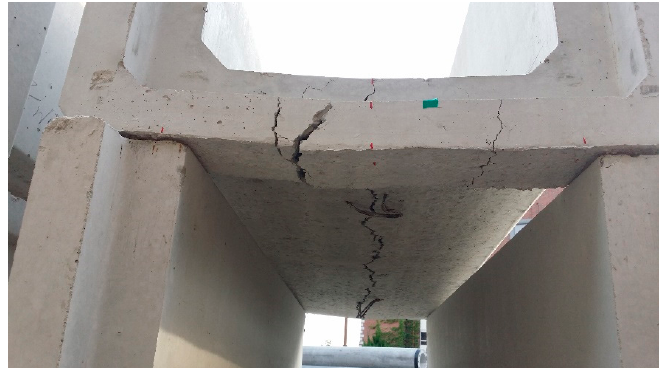
Figure 9. Crack patterns of the LWGP concrete flume. Materials 2019 , 12 , x FOR PEER REVIEW